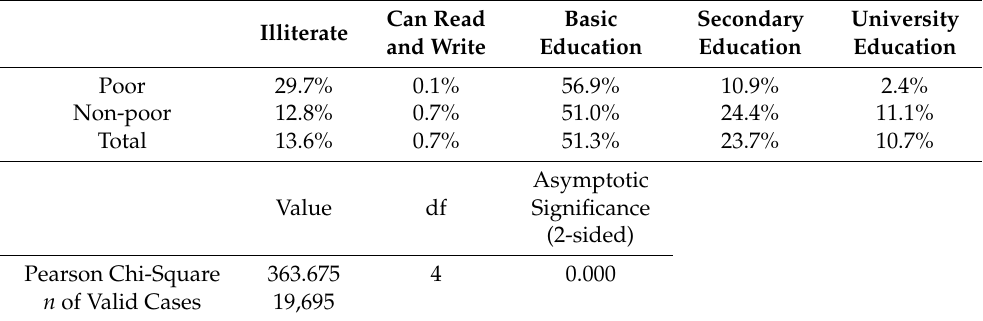
Table 3. Distribution of youth 18–29 years by education and poverty status, 2014.